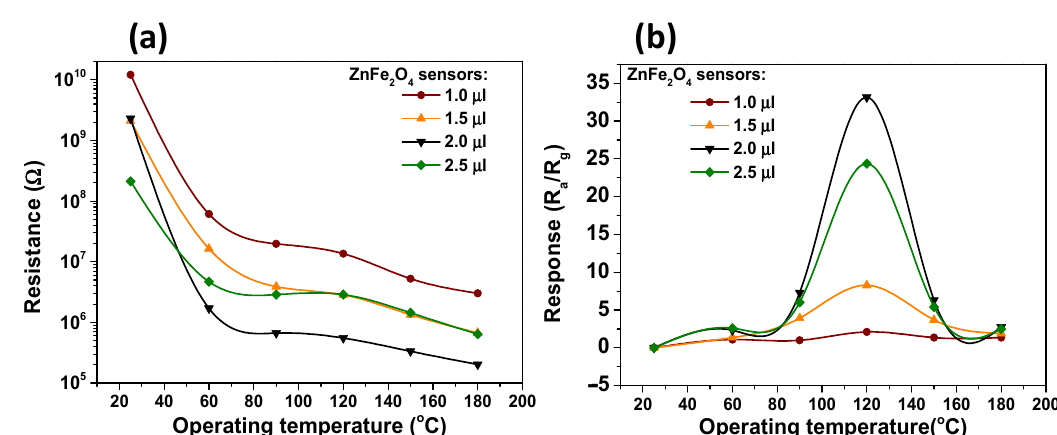
Figure 6. ( a ) Resistance in air and ( b ) responses of the active ZnFe 2 O 4 NP sensing layers produced at volumes of 1.0, 1.5, 2.0, and 2.5 µL against the operating temperature ranging from 25 to 180 °C.